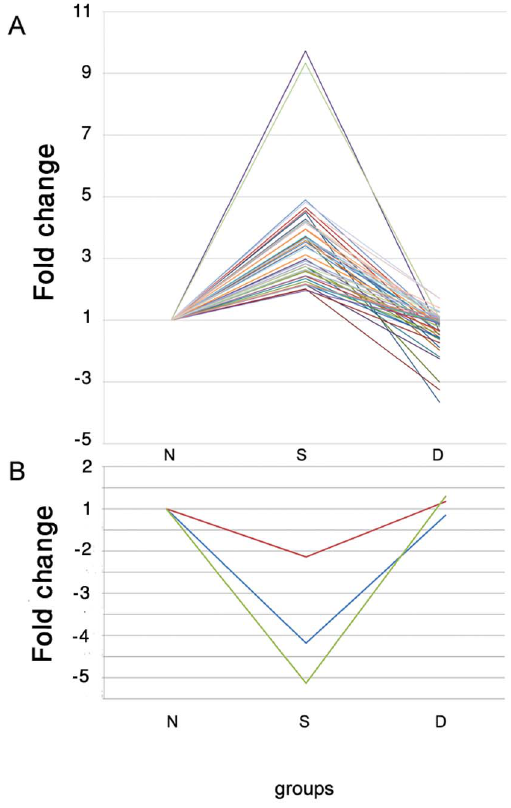
Figure 2. Expression trend of transcripts altered by XOSG ablation and restoring their native level following D-cHH injection. A Up-regulated transcripts following XOSG ablation. B Down-regulated transcripts following XOSG ablation.